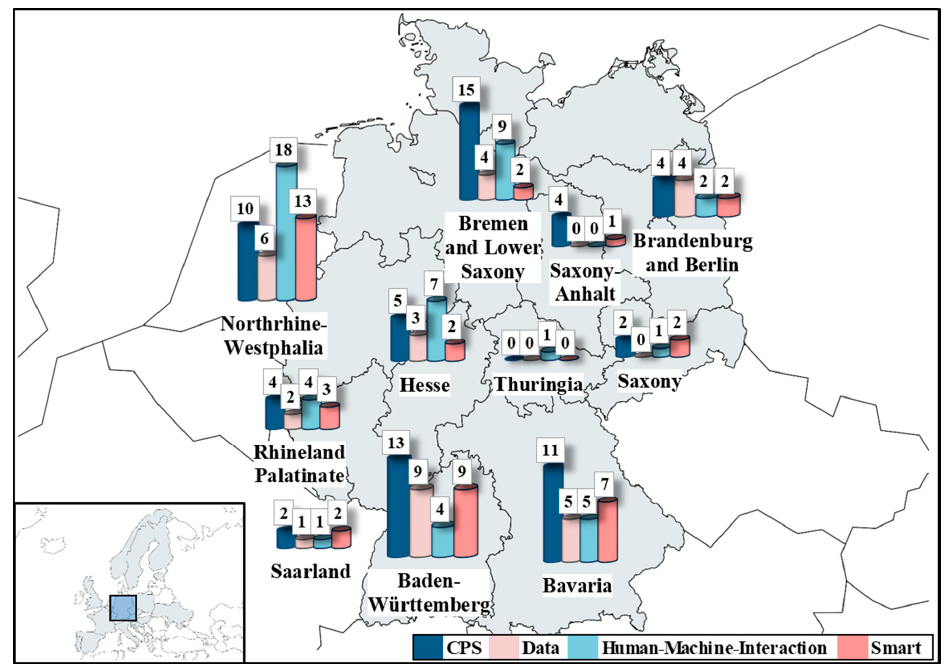
Figure 9. Papers identified in the correlated national analysis; Source of shapefile